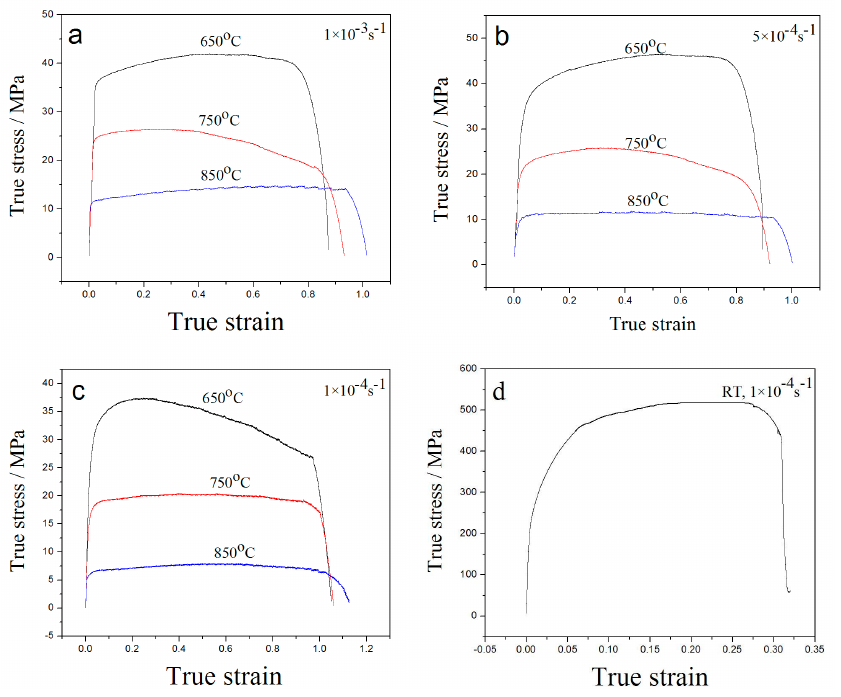
Figure 3. True stress–strain curve: ( a ) 1 × 10 − 3 s − 1 ; ( b ) 5 × 10 − 4 s − 1 ; ( c ) 1 × 10 − 4 s − 1 ; ( d ) room temperature.